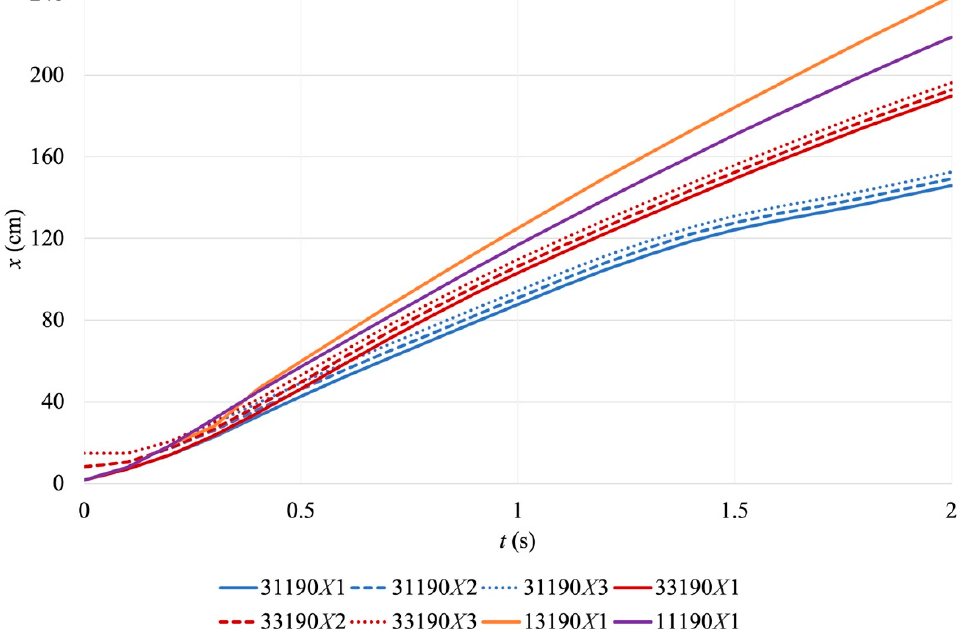
Figure 16. Comparison of the location of each column’s center of gravity in the x direction after starting the drift. starting the drift.